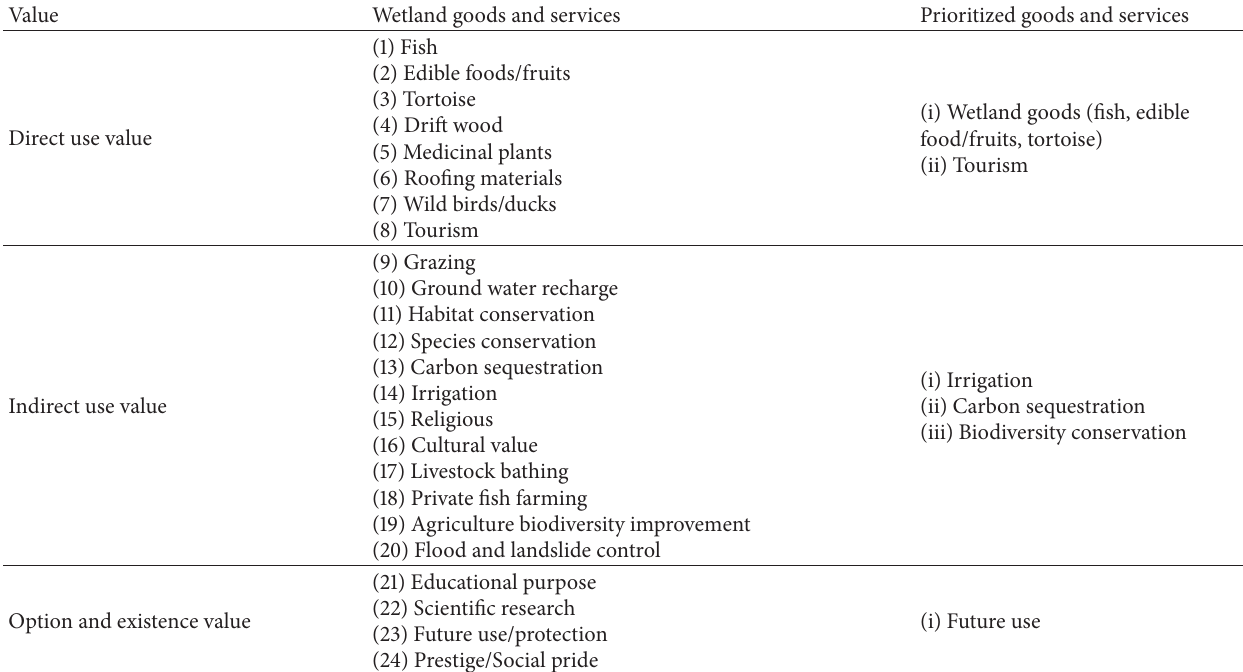
Table 3: Wetland goods and services from Jagadishpur